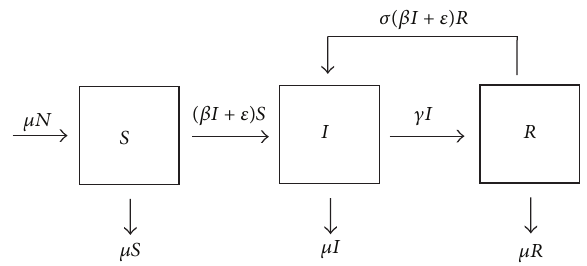
Figure 1: Flow diagram of the Ejima et al.